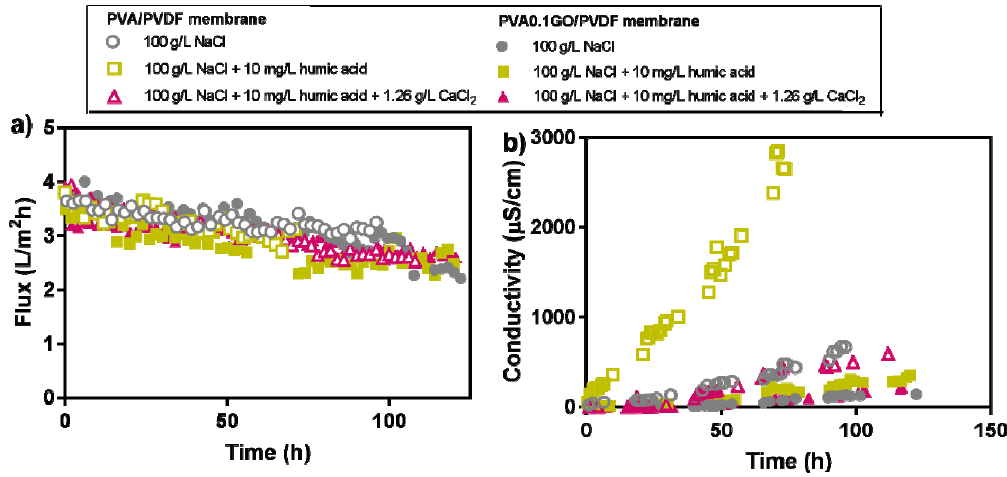
Figure 10. ( a ) Flux and ( b ) permeate conductivity profiles of the composite membrane PVA/PVDF, and PVA0.1GO/PVDF prepared by cast coating method using different feed solution. Table 4. Permeate property of membrane PVA0.1GO/PVDF at different operation time by using